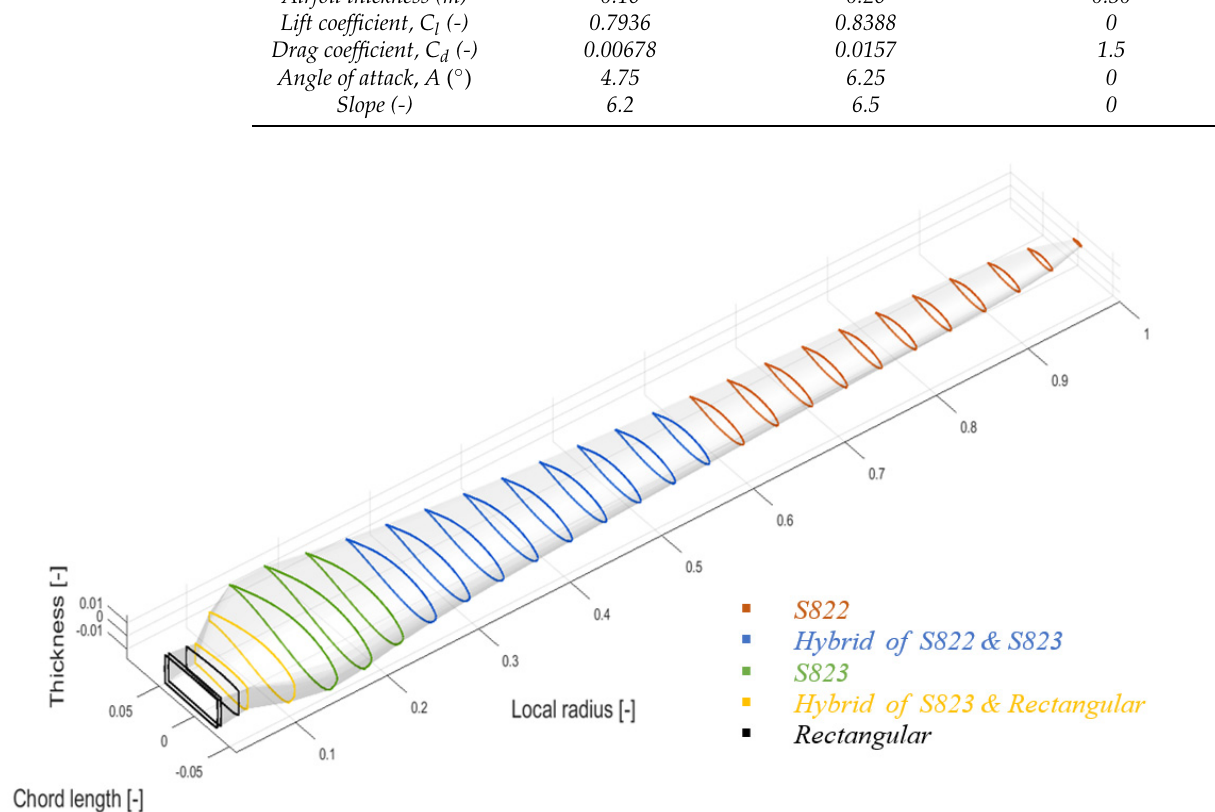
Figure 3. Sample arrangement of the different airfoils along the span of the blade.